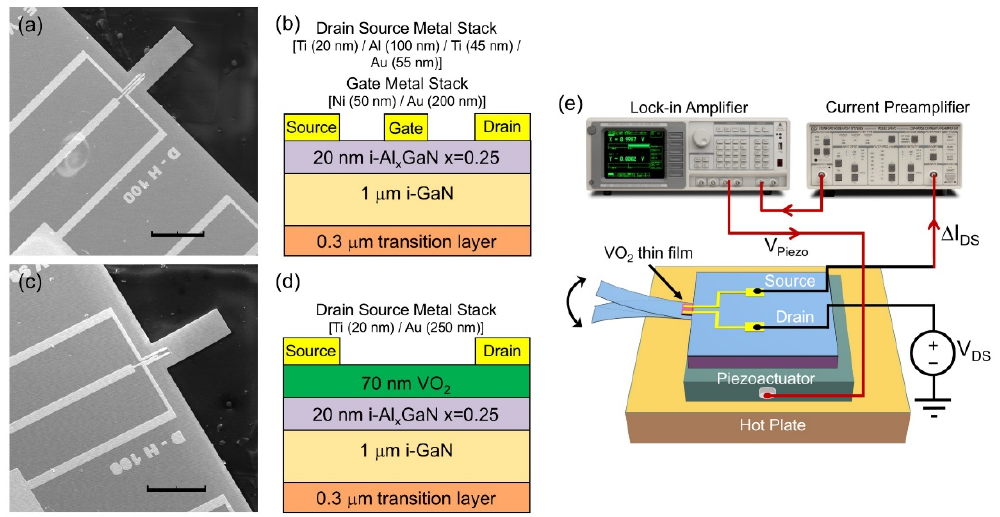
Figure 1. ( a ) Scanning electron microscope (SEM) image of an AlGaN/GaN heterojunction field effect transistor (HFET) embedded GaN microcantilever with dimensions of 100 × 250 μ m. Scale bar is 200 μ m. ( b ) Layer structure of the fabricated AlGaN/GaN HFET. The transition and i-GaN layers form the thickness of the microcantilevers. ( c ) SEM image of VO 2 thin film embedded GaN microcantilever with dimensions of 100 × 250 μ m. Scale bar is 200 μ m. ( d ) Layer structure of the VO 2 thin film embedded microcantilever. Similarly to the AlGaN/GaN HFET embedded microcantilever, the transition and i-GaN layers form the microcantilever thickness. ( e ) Schematic of the experimental setup utilized to characterize the VO 2 thin film based GaN microcantilever.